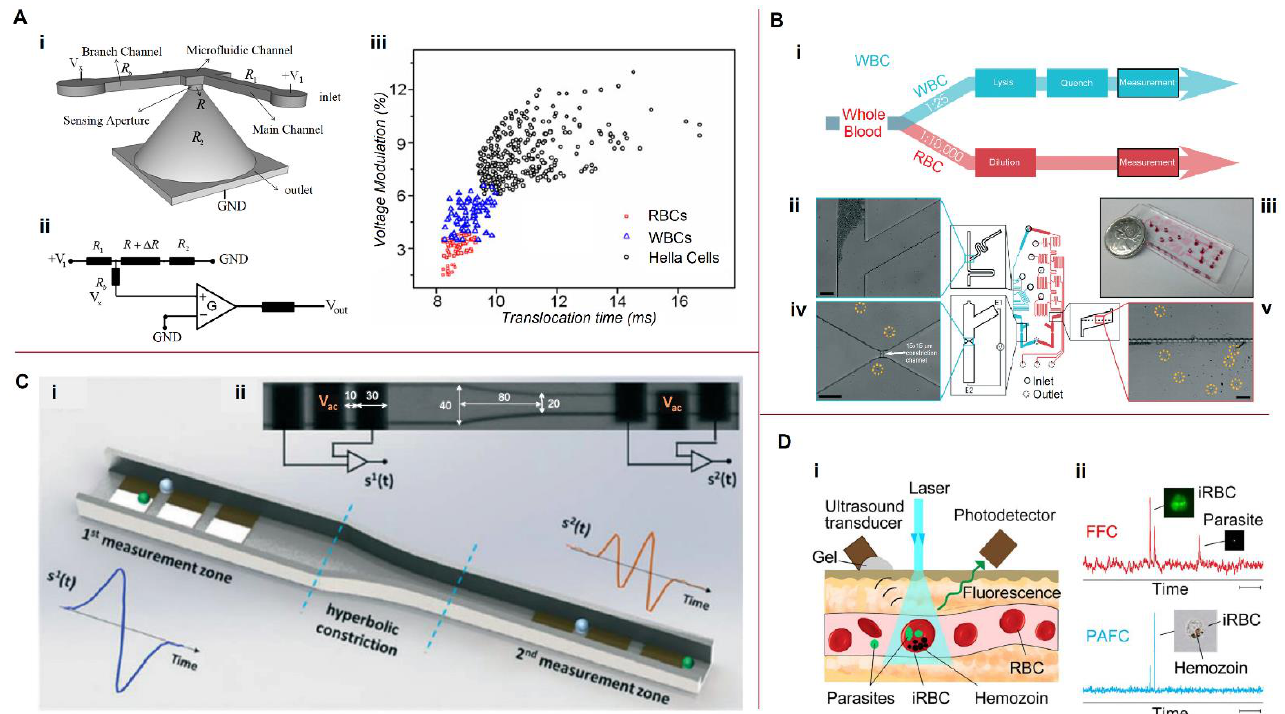
Figure 5. Microfluidic cytometry devices. ( A ) Detection and enumeration of biological cells: ( i ) Design of the micropore. ( ii ) Equivalent electric circuit of the device. ( iii ) Scatter plot of the peak amplitude and translocation time for a mixed cell sample. Reproduced with permission from [119].